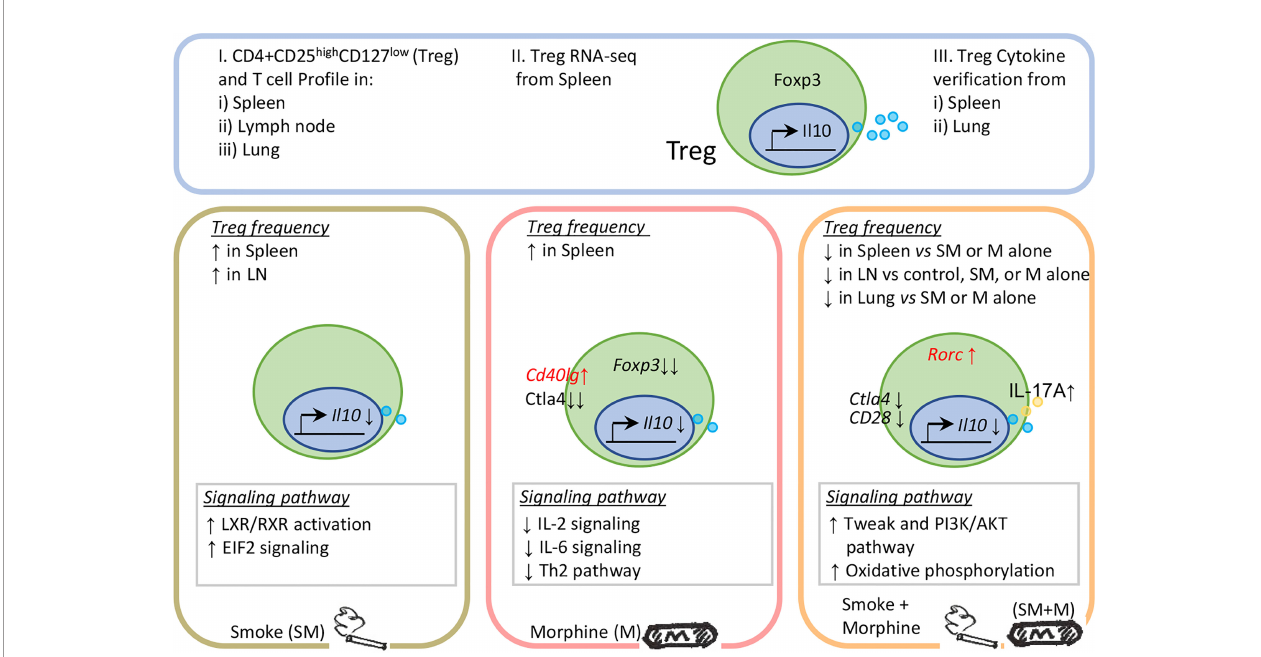
FIGURE 5 | Working model: Chronic exposure to the combination of cigarette smoke and morphine decreases CD4+ regulatory T cell numbers by reprogramming the Treg cell